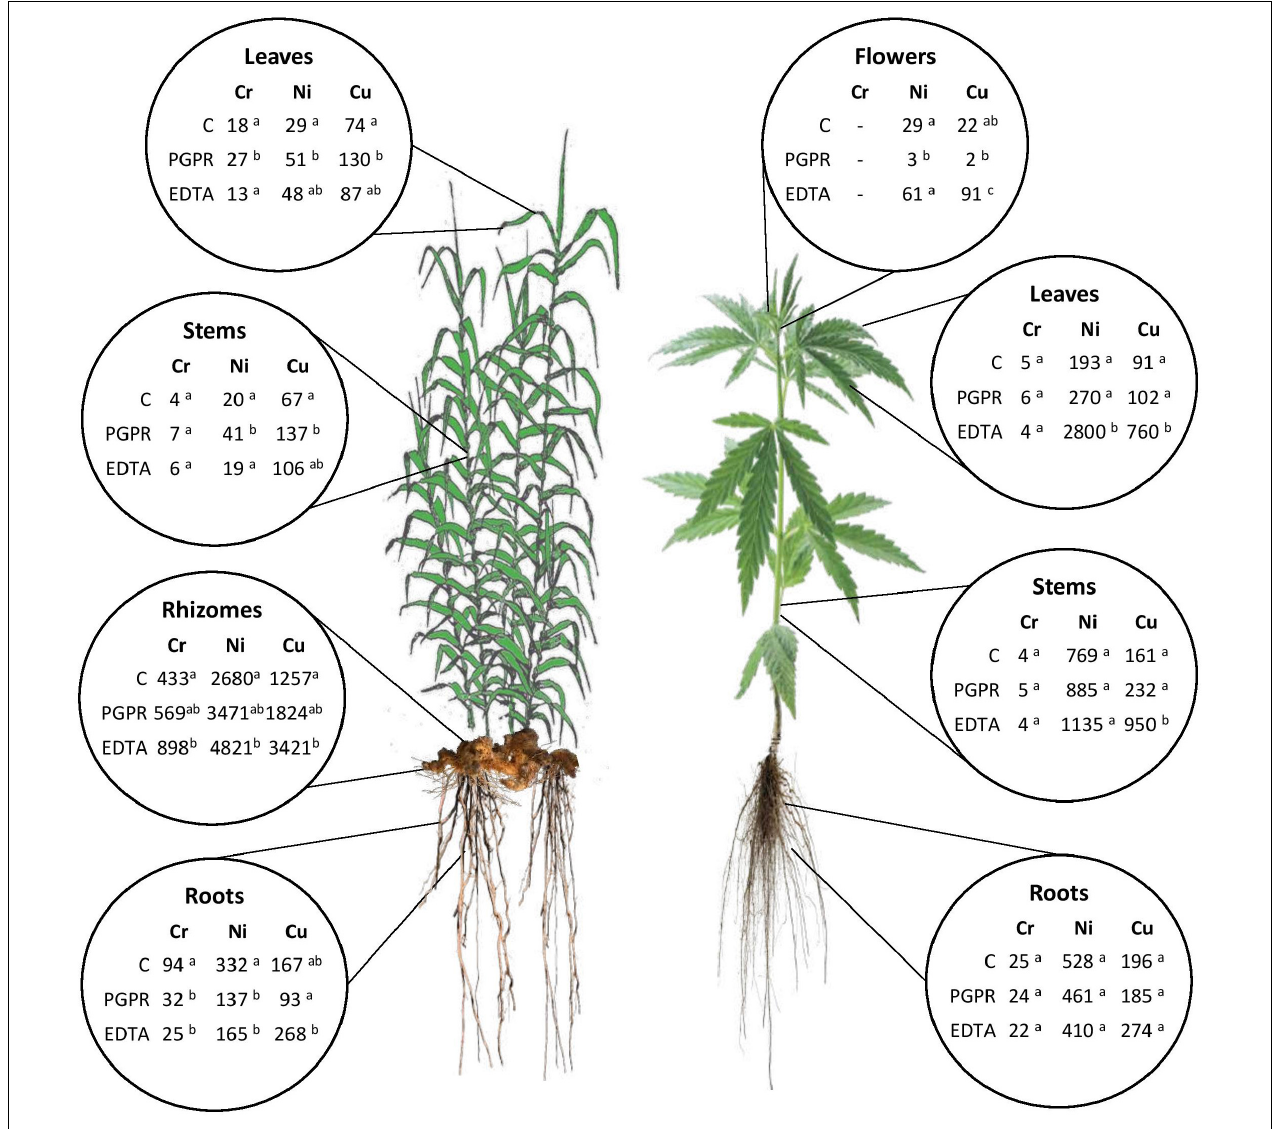
FIGURE 2 | Summary of mean values of Cr, Ni, and Cu uptake ( µ g HM plant − 1 ) in plant components for hemp and giant reed as affected by treatments. Different letters denote statistically different (Tukey’s test, P = 0.05) uptake values among treatment for each HM.